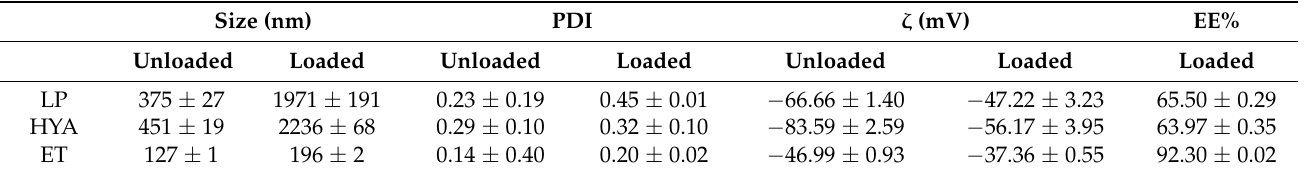
Table 3. VS, PDI, ζ potential and EE of LP, HYA, and ET, unloaded and loaded with RCL extract. Size (nm) PDI ζ (mV) EE% Unloaded Loaded Unloaded Loaded Unloaded Loaded